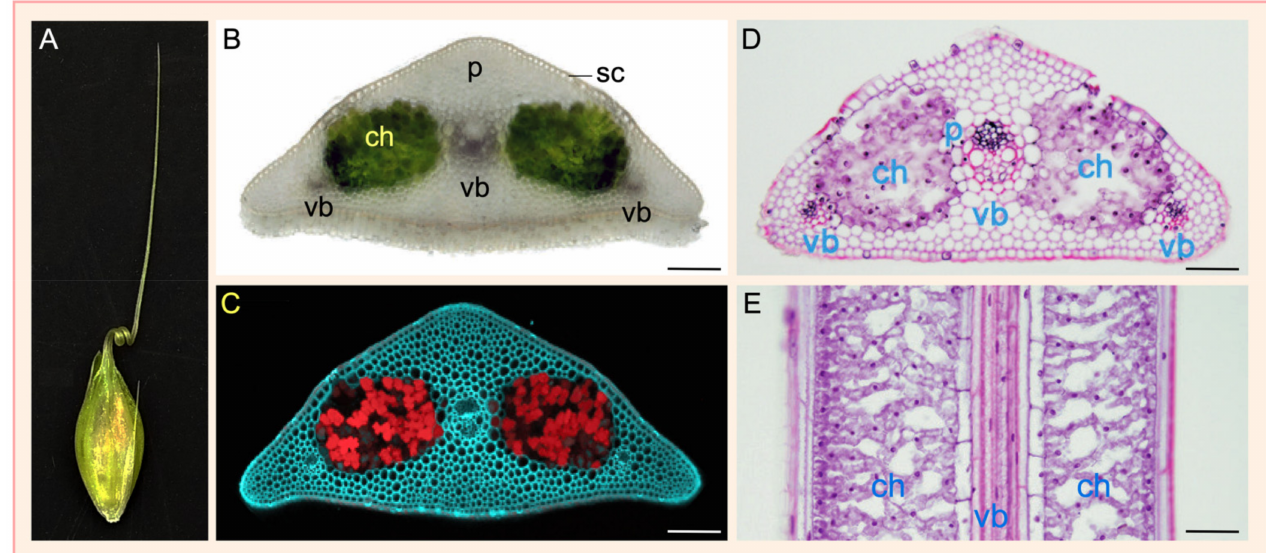
Figure 1. Anatomical structures of barley awns. ( A ), The awn is a characteristic floret organ and an extension of the lemma of spikelets in barley. Shown is a twisted awn of the barley ari-a mutant grown in the green house of the University of Idaho, photo taken by B.H. ( B , C ), A transverse section of a typical barley awn. The chlorenchyma cells (ch) are green under transmission light microscopy due to the presence of chlorophylls ( B ) but are red under a fluorescent microscope because of the autofluorescence of chlorophylls ( C ). ( D , E ), Transverse and longitudinal awn sections of barley cultivar Bowman under a light microscope after staining with Safranin O, a red dye for nuclei and cell walls. On a longitudinal awn section, the chlorenchyma cells are organized as two long strands that are placed among the three vascular bundles (vb). The chlorenchyma cells are active in photosynthesis and provide a major contribution of carbon sources for grain filling. p, parenchyma cells; sc, sclerenchyma cells. Bars, 100 µ m. Images of ( B , C ) are taken from [11] and ( D , E ) from [12], with permissions from